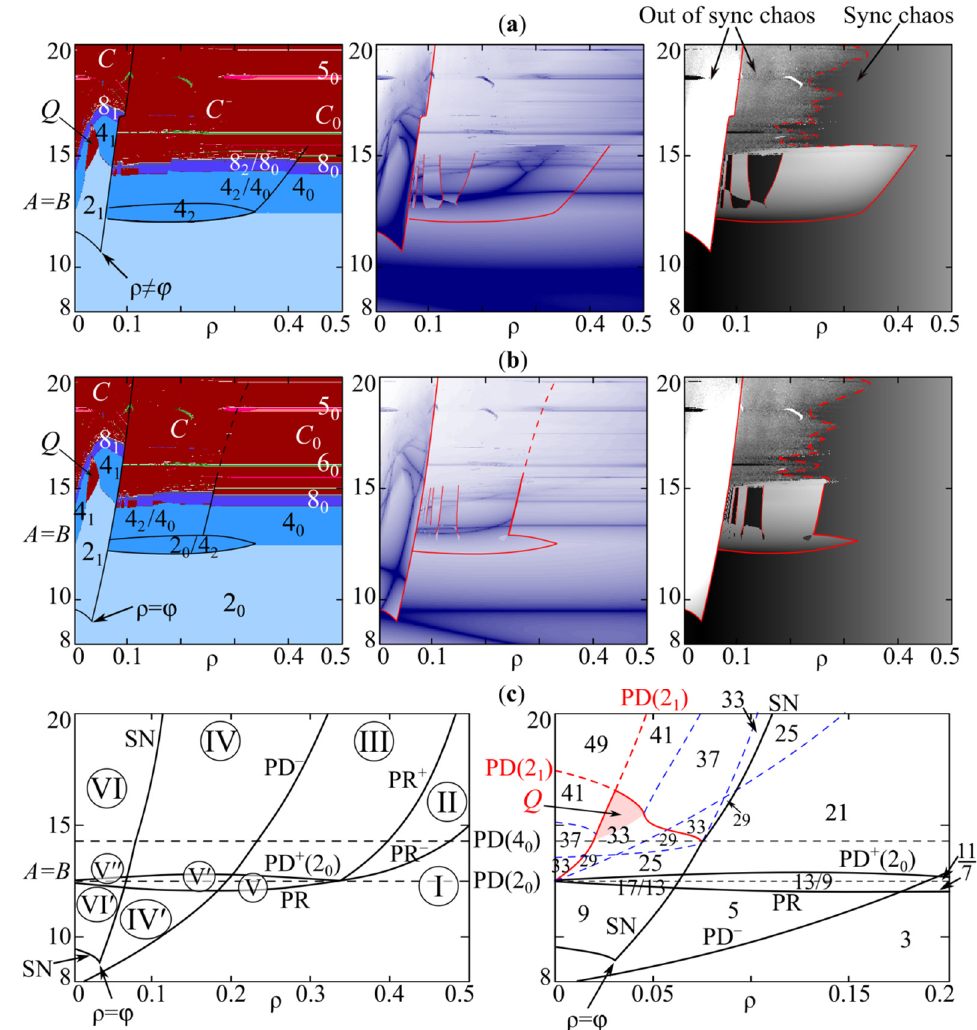
Figure 9. ( a , b ) Dynamic mode maps ( left ), maps of sums of Lyapunov exponents ( center ) and synchronization index maps ( right ) for asymptotic dynamic modes of system (4) at φ = 0.03 and starting point ( a ) x 0 = 1.7, y 0 = 5 and ( b ) x 0 = 0.8, y 0 = 4.3 with changing A = B and ρ . The line highlights the approximate boundary between dynamics modes with different values of the synchronization index. Figures correspond to the period of observed cycles. Q stands for quasiperiodic dynamics. C is chaotic dynamics. Subscript is the phase shift of variable x n relative to y n . ( c ) Bifurcation diagram of system (4), where domains Ⅰ – Ⅵ differ in multistable dynamics modes. Figures correspond to the number of system (16) fixed points (right). A numerator is fixed points’ amount between PD(2 0 ) and PD + (2 0 ) lines, the denominator corresponds to those between PR and PD(2 0 ) lines. Period-doubling bifurcations are shown by the dashed lines or designated as PD( T τ ), where T τ is a periodic point that doubles its period.